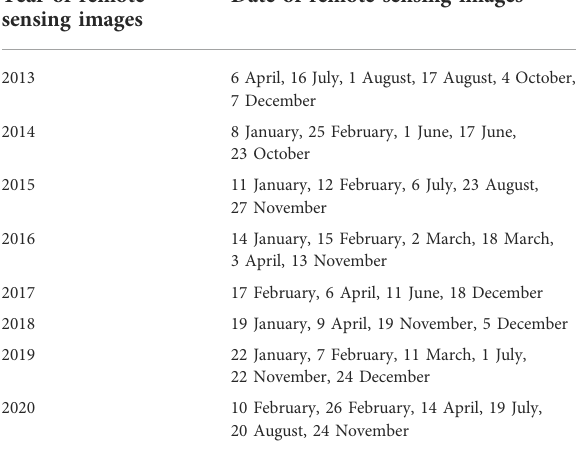
Date of remote sensing